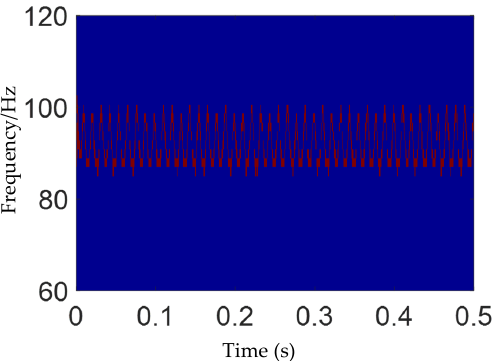
Figure 17. Time – frequency distribution obtained by the SET.